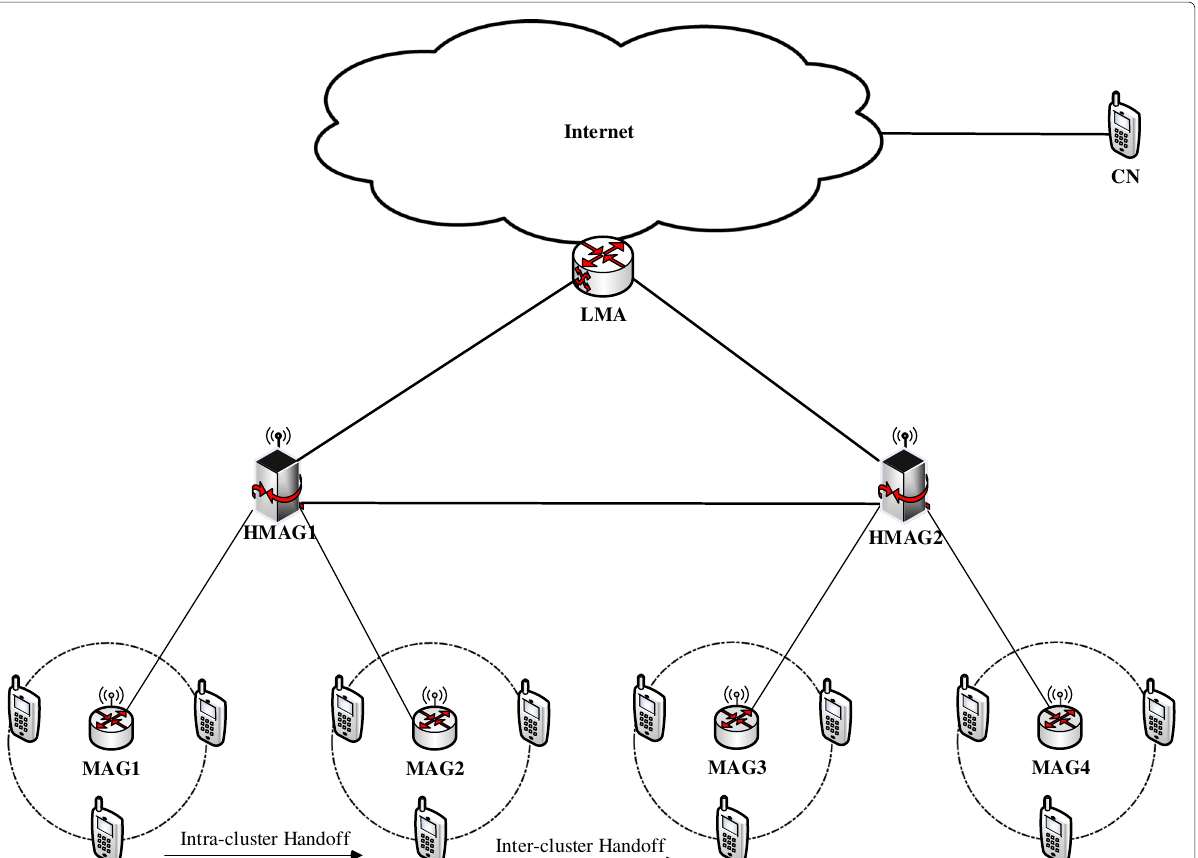
Fig. 1 Overall CSPMIPv6 system